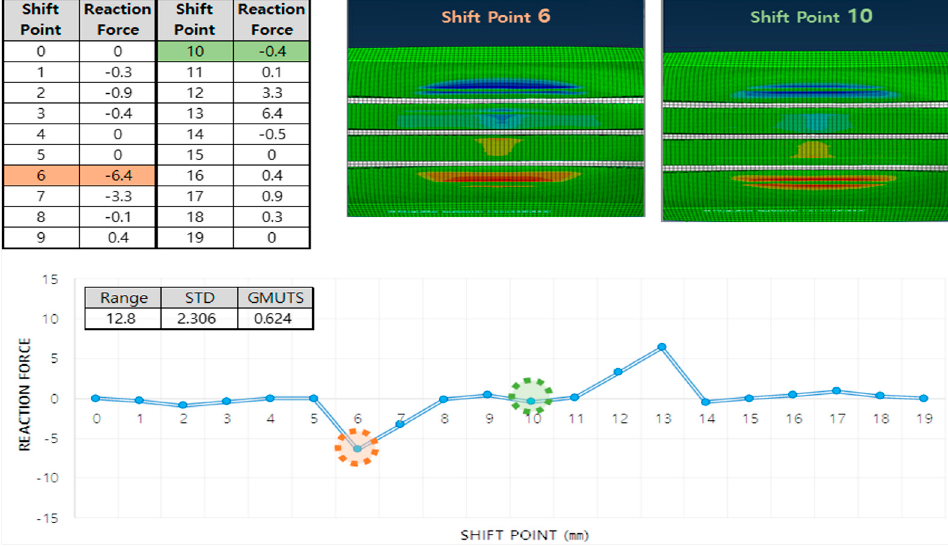
Figure 4. Result of finite element analysis for the 2 × 3 × 19 mm.